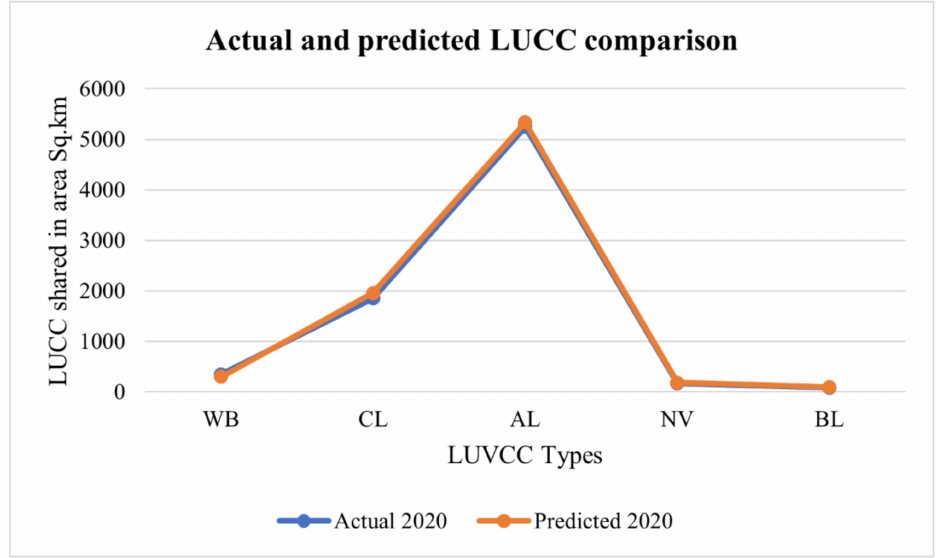
Figure 11. Validation between LU predicted and actual LU 2020. (Note: WB—Water bodies, CL— Construction land, AL—Agricultural land, NV—Natural vegetation, BL—Bare